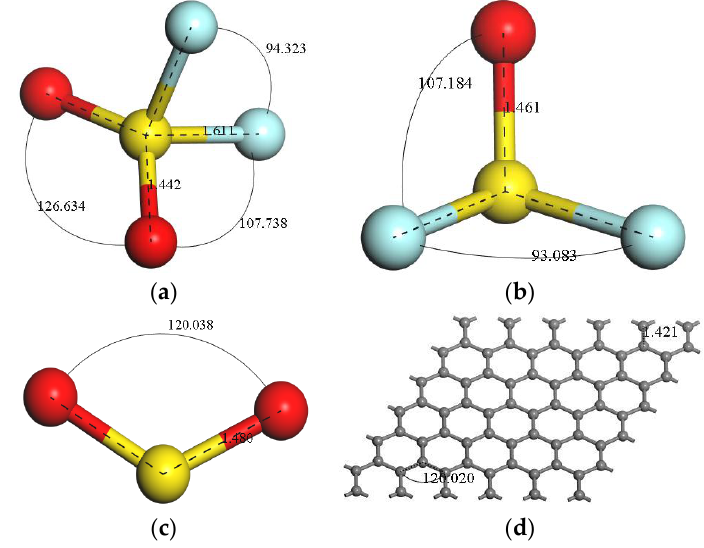
Figure 1. Geometric structures after optimization in ( a ) SO 2 F 2 molecule; ( b ) SOF 2 molecule; and ( c ) SO 2 molecule and ( d ) Int-graphene.